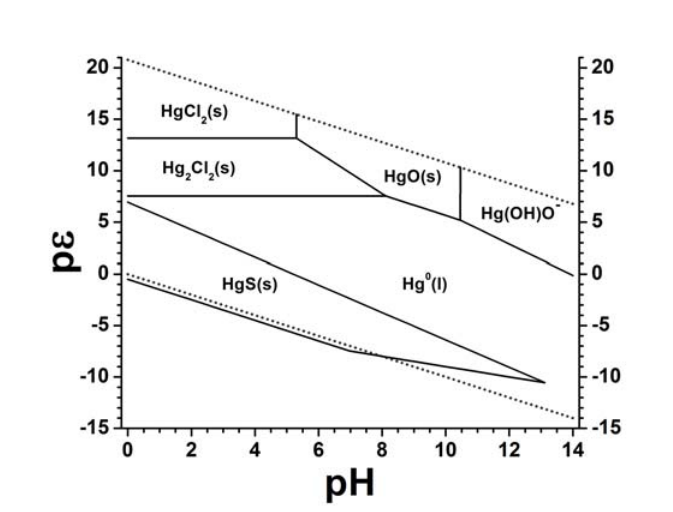
Figure 2. Pourbaix diagram for Hg solid phases, in contact with a water solution with Cl (cid:2879) and SO (cid:2872)(cid:2870)(cid:2879) concentrations of 10 − 3 mol/kg at 1 bar total